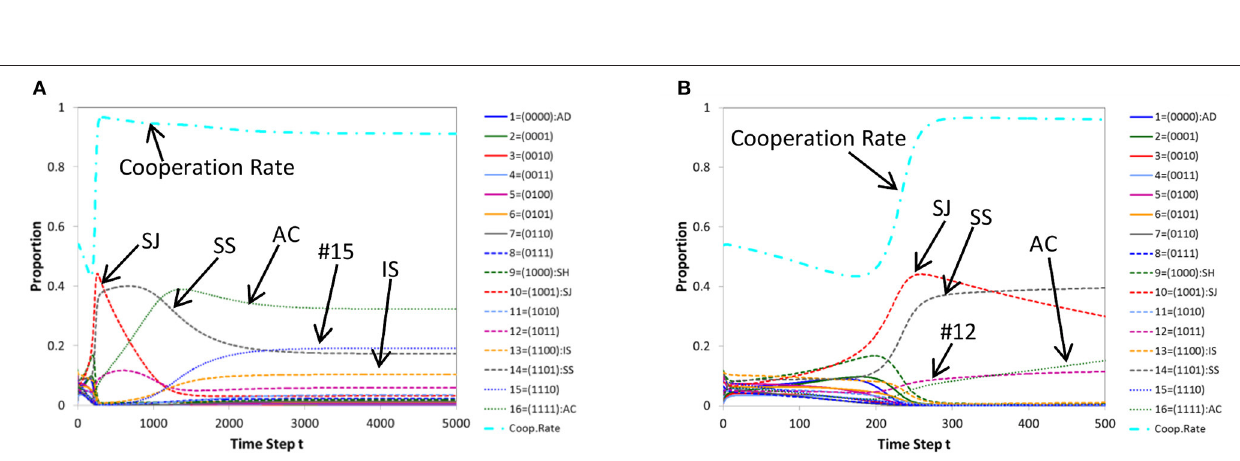
FIGURE 4 | A typical pattern of time evolution of norms’ frequencies and the cooperation rate in the population generated by replicator dynamics with multiple models (A) and its initial part (the first 500 steps) (B) for a case where cooperation is achieved. Parameters: c = 1, b = 7, µ = 0.005, dt = 0.2.